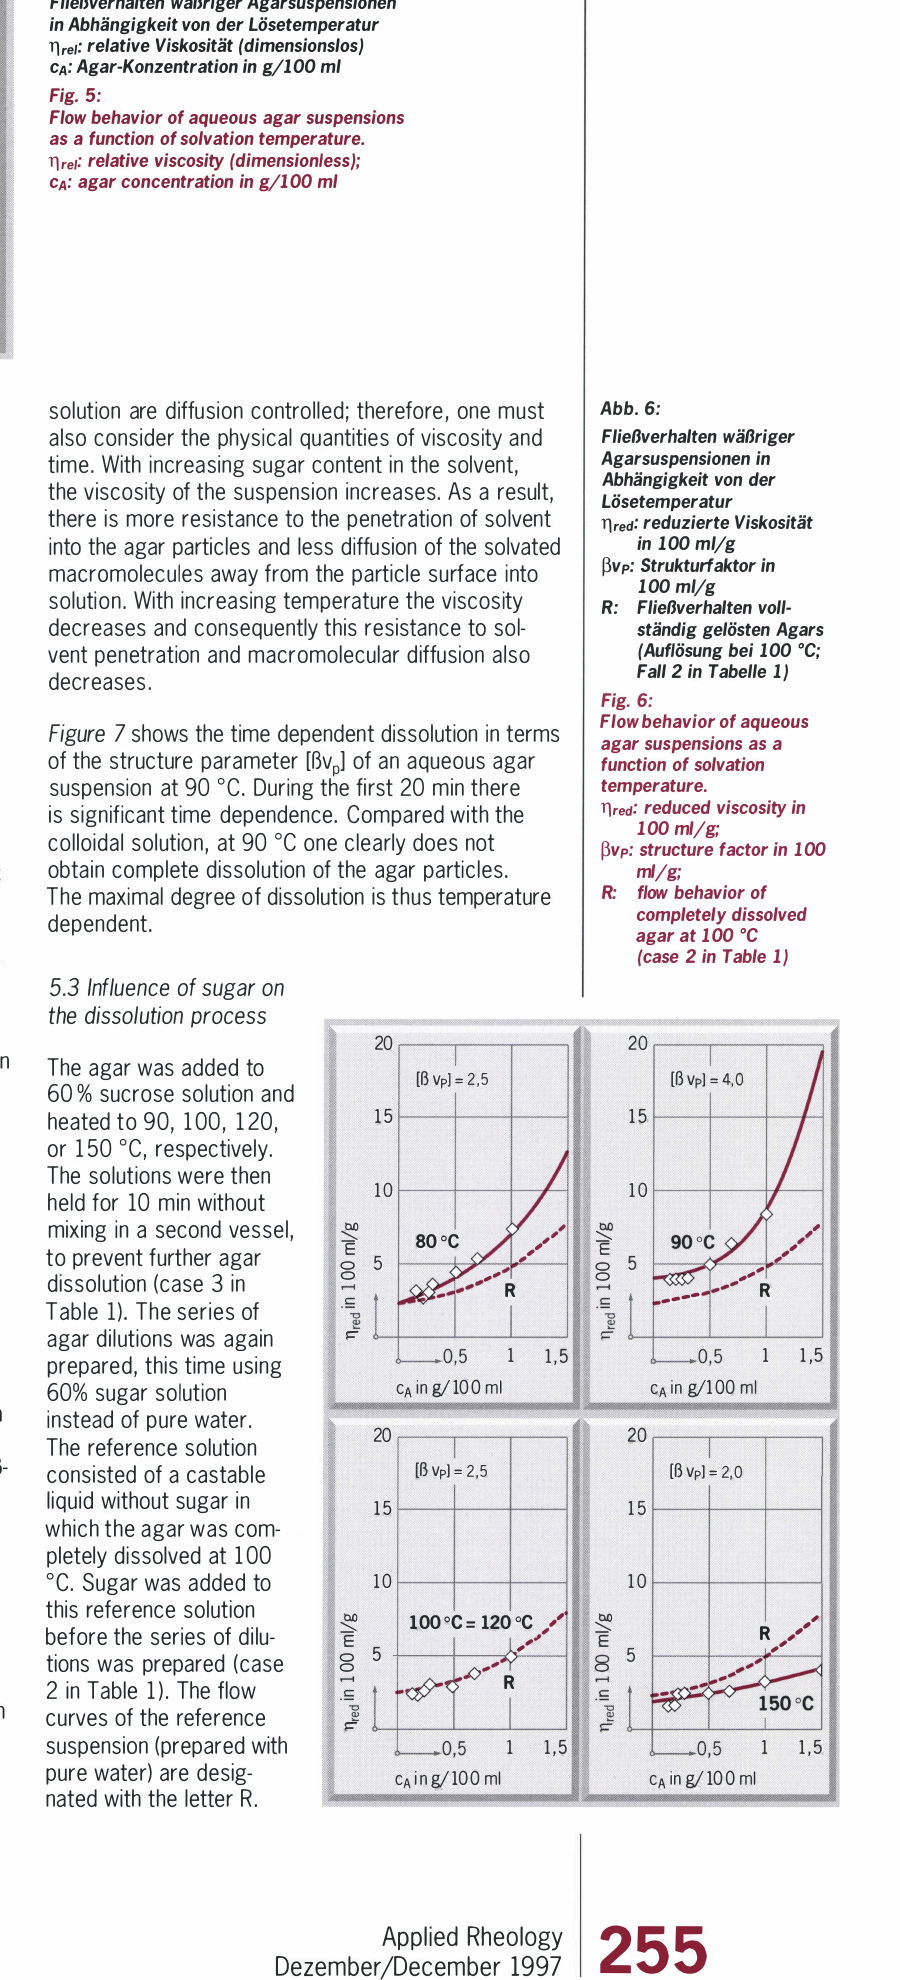
Fig. 5: Flow behavior of aqueous agar suspensions as a function of solvation temperature.